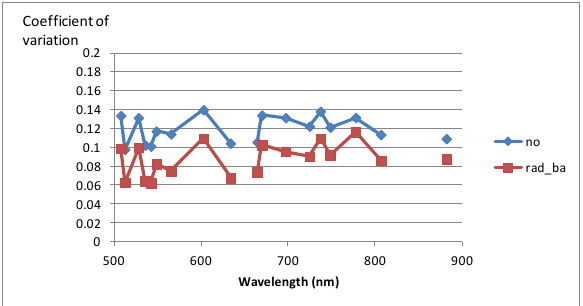
Figure 7. Coefficient of variation at radiometric tie points without any radiometric corrections (no) and with radiometric block adjustment with relative offset parameters (rad_ba).